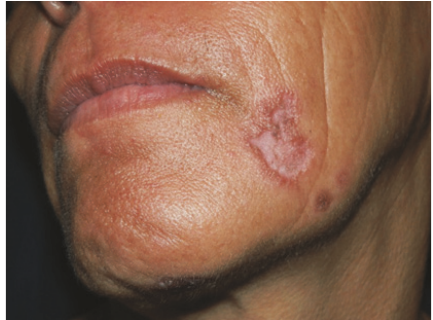
Figure 1: Plaque on chin before Penicillin G treatment.